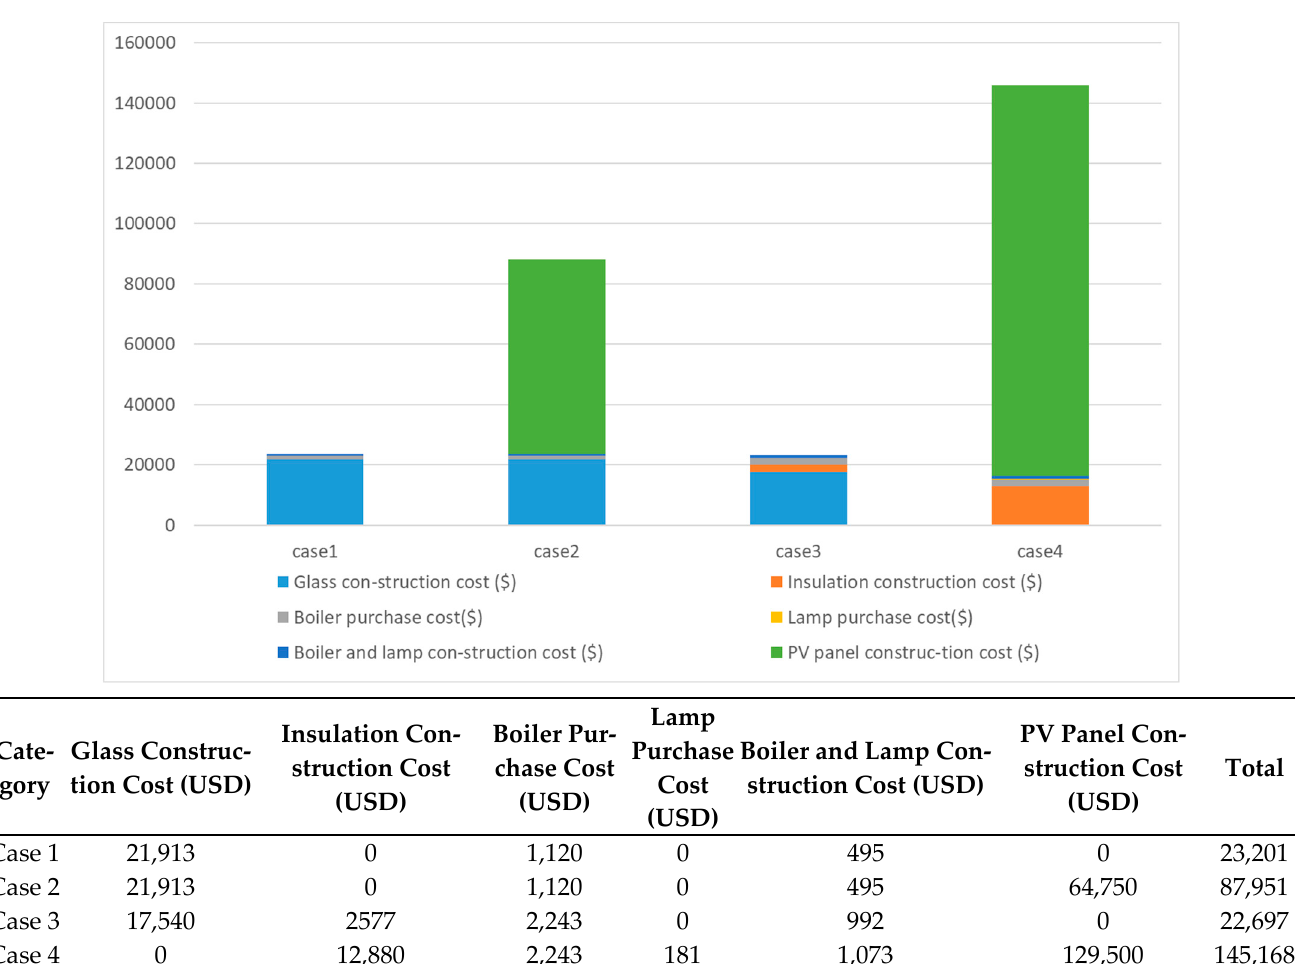
Figure 3. Case-wise construction costs.